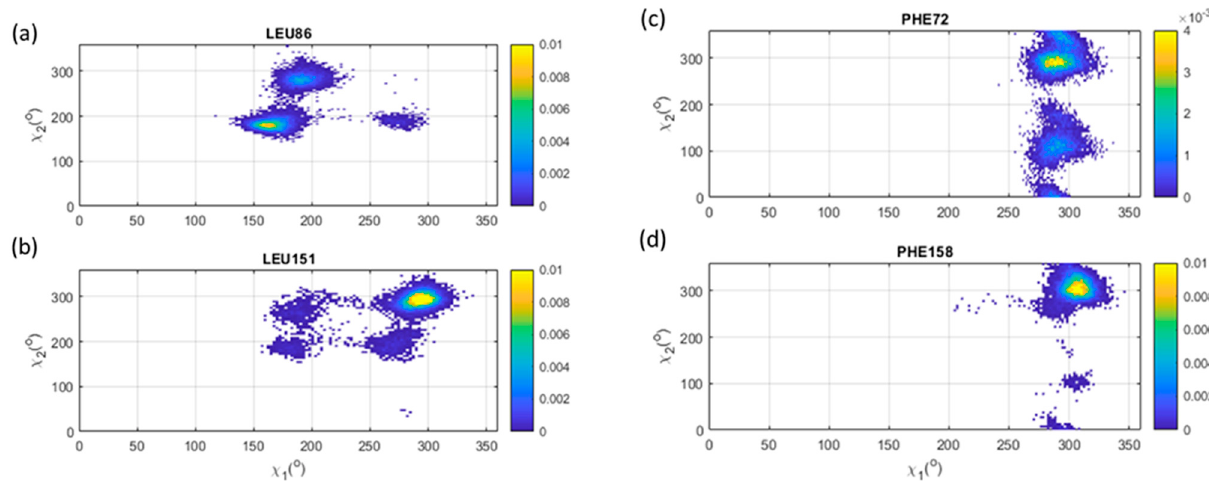
Figure 5. Color map of side-chain torsions probability density distributions P( χ 1, χ 2) for Leu86, Leu151 ( a , b ) and aromatic residues Phe72, Phe158 ( c , d ). The probability values within each of the 5° × 5° bins increase from deep blue to yellow according to the color map.